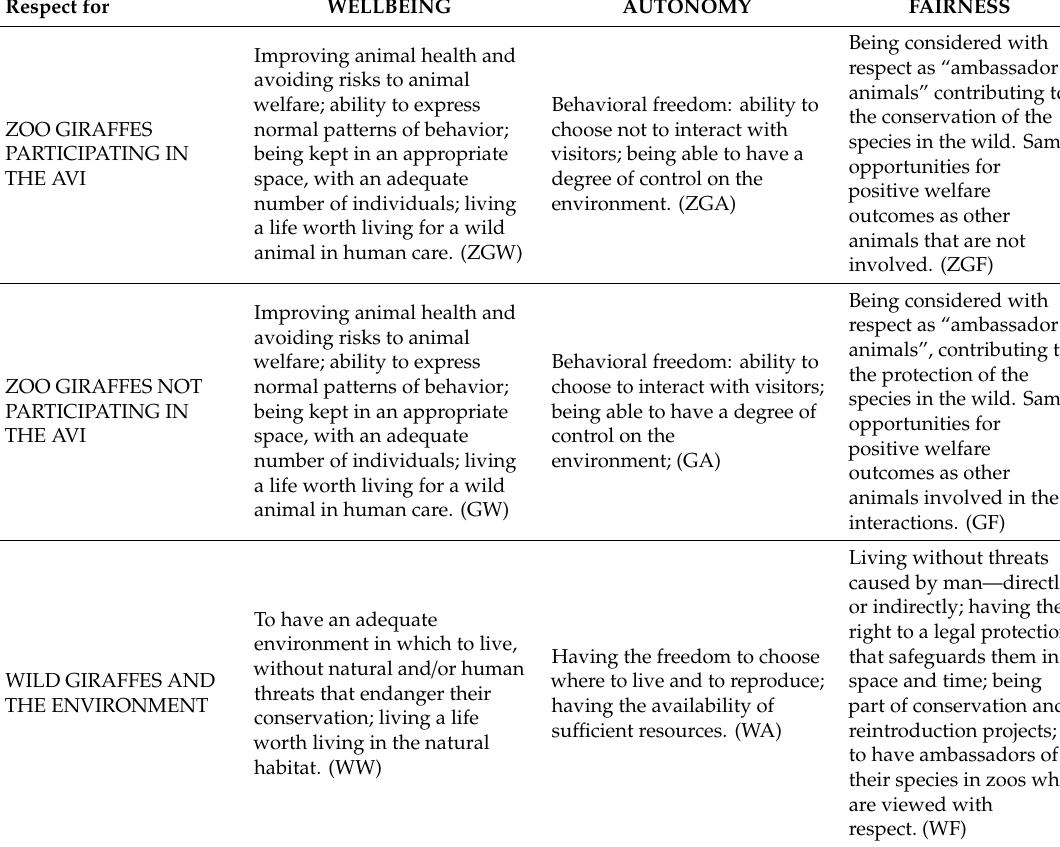
Table A11. Customized ethical